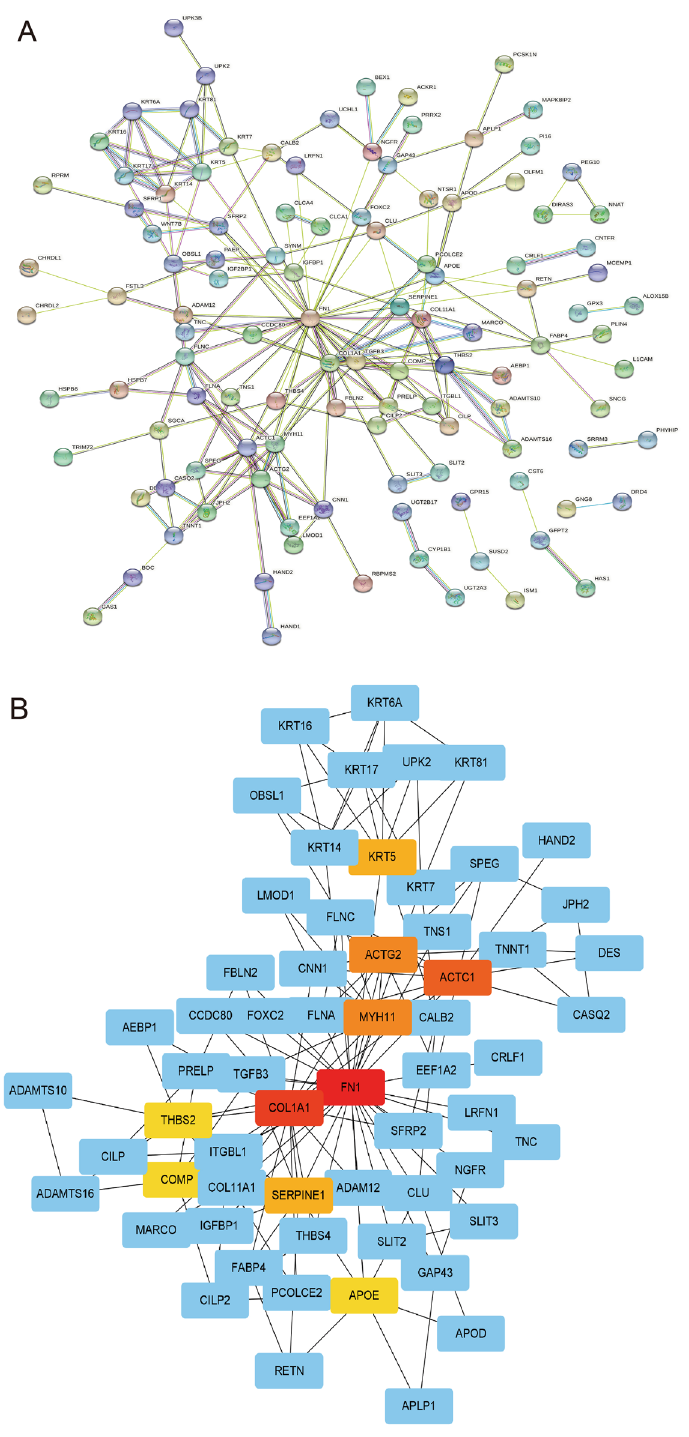
Figure 8. Identification of hub genes. ( A ) PPI network of differentially expressed genes between high- and low- risk groups. ( B ) Top 10 hub